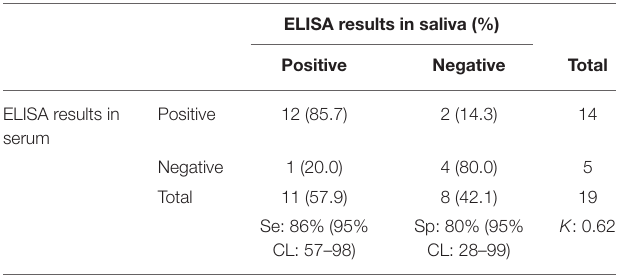
TABLE 2 | Number of porcine serum and saliva samples positive and negative for anti-Salmonella IgG antibodies. ELISA results in saliva (%) Positive Negative Total ELISA results in